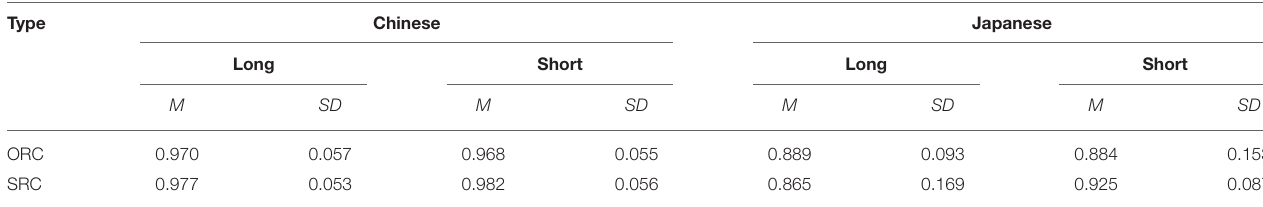
TABLE 2 | Mean ( M ) and standard deviation ( SD ) values for the accuracy of the post-stimulus reading comprehension test. Type